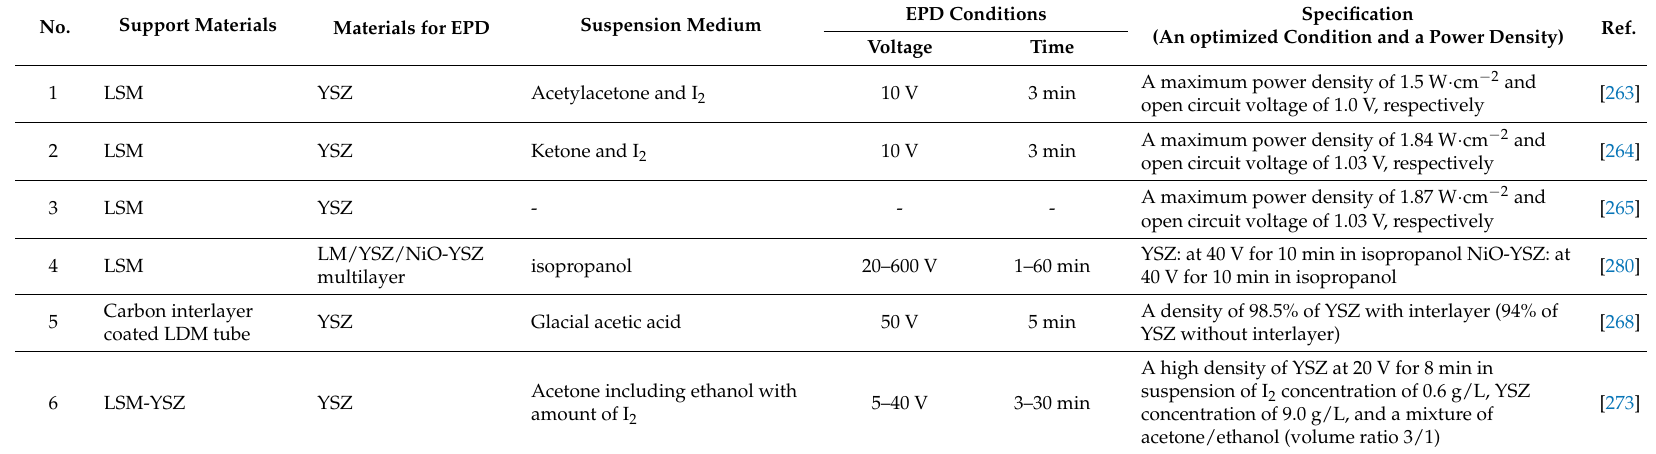
Table A4. Overview of the SOFCs fabricated by EPD showing the materials for SOFCs and EPD conditions